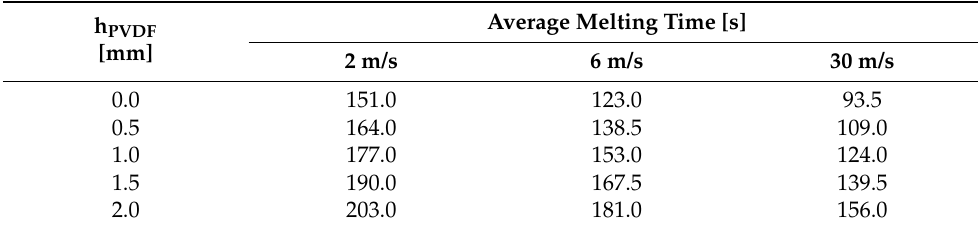
Figure 6. Evolution of the average n-eicosane core temperature. The temperature is calculated for different shell thicknesses of 0.5 and 2.0 mm and working fluid velocities (2, 6 and 30 m/s). Table 2. Average melting time of n-eicosane depending on the PVDF shell thickness and ammonia